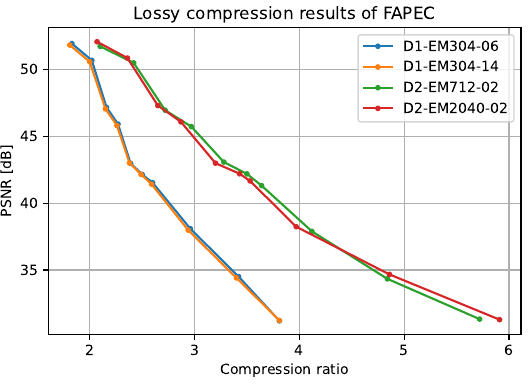
Figure 14. Quality (PSNR) of the reconstructed water column files at different FAPEC lossy